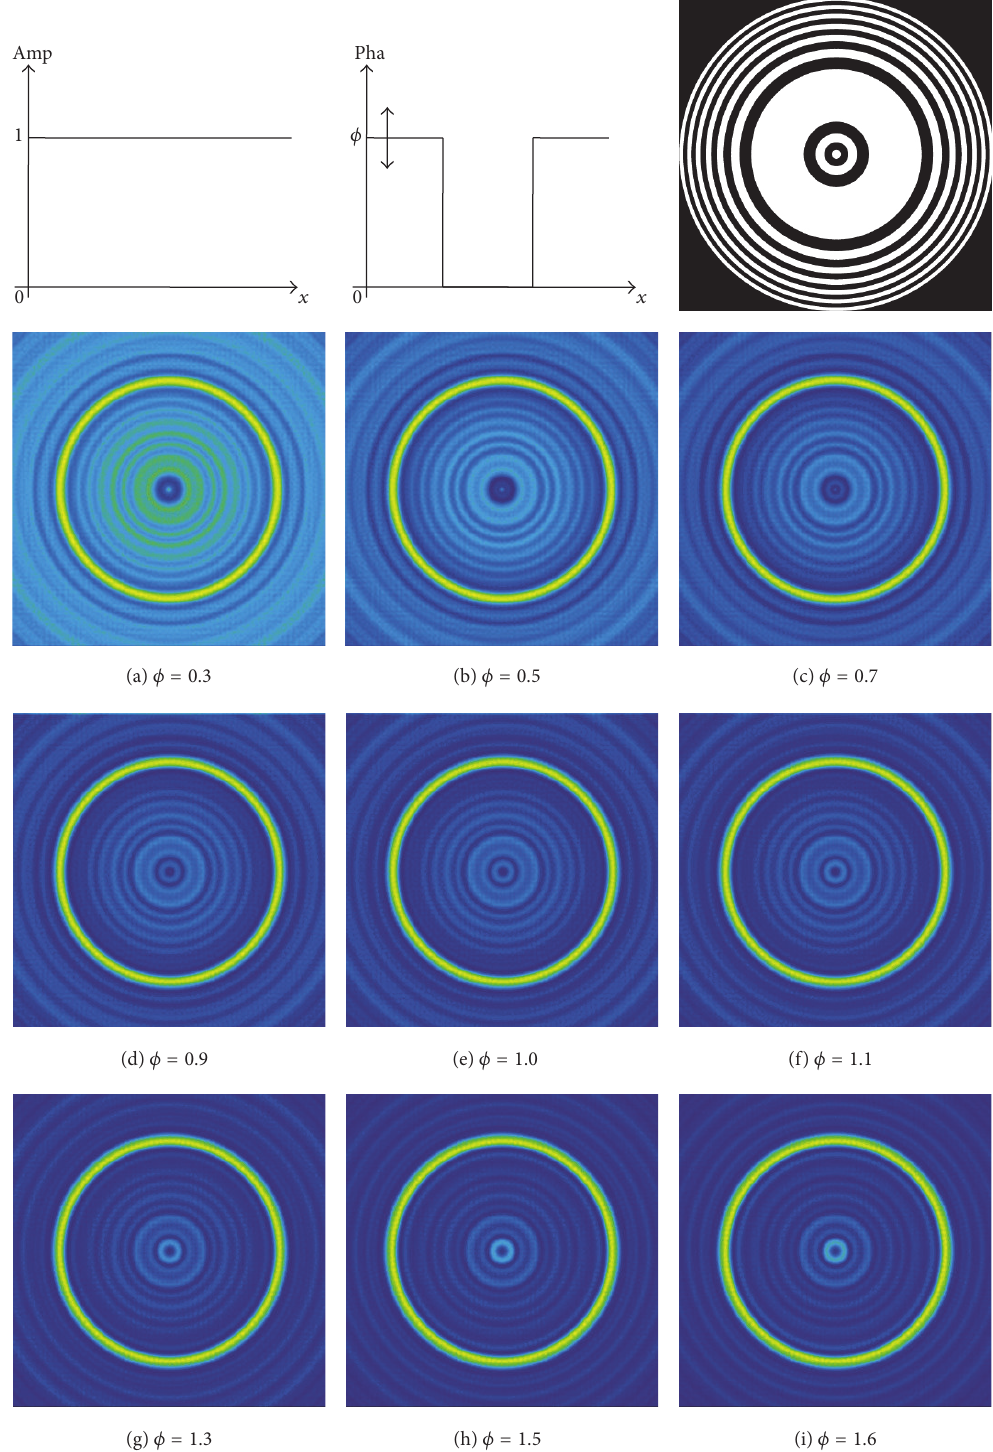
Figure 6: The simulation parameters (amplitude and phase diagrams together with the structure’sphase distribution). Intensity distributions (simulation results) for different phase mismatchfor ideal diffractive lens. Simulations were conducted for introduced phase delays as follows: 0.3, 0.5, 0.7, 0.9, 1.0, 1.1, 1.3, 1.5, and 1.6, shown in (a)–(i),